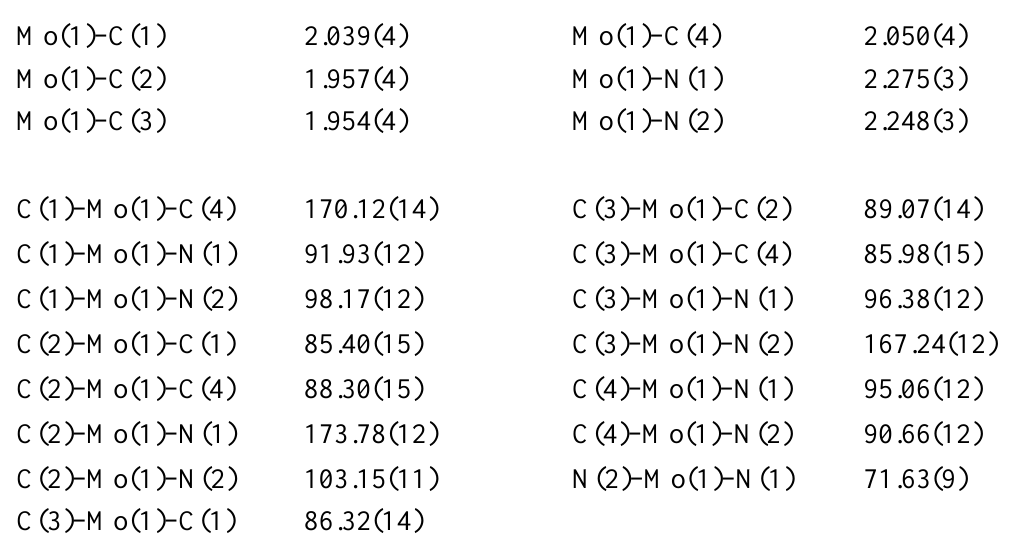
Table 1. Bond lengths (Å) and angles (º) for the octahedral {MoC environment of the complex cis -[Mo(CO)